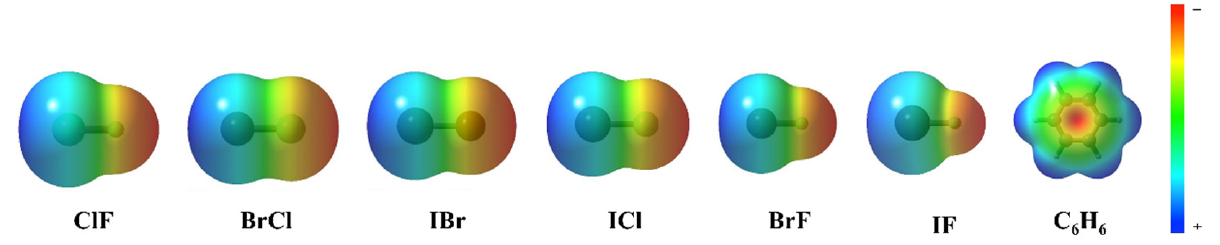
Figure 4. The electrostatic potential of ClF, BrCl, IBr, ICl, BrF, IF and C 6 H 6 .